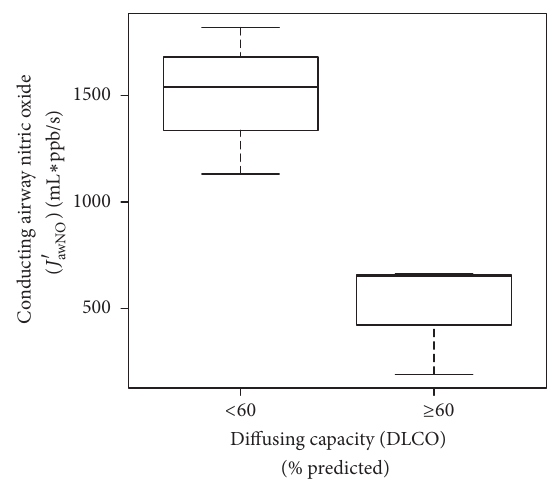
Figure 1: Relationship of conducting airway nitric oxide to diffusing capacity in SSc-PAH. Box plot illustrating increased conducting airway exhaled nitric oxide has discriminative validity in SSc-PAH subjects with reduced diffusing